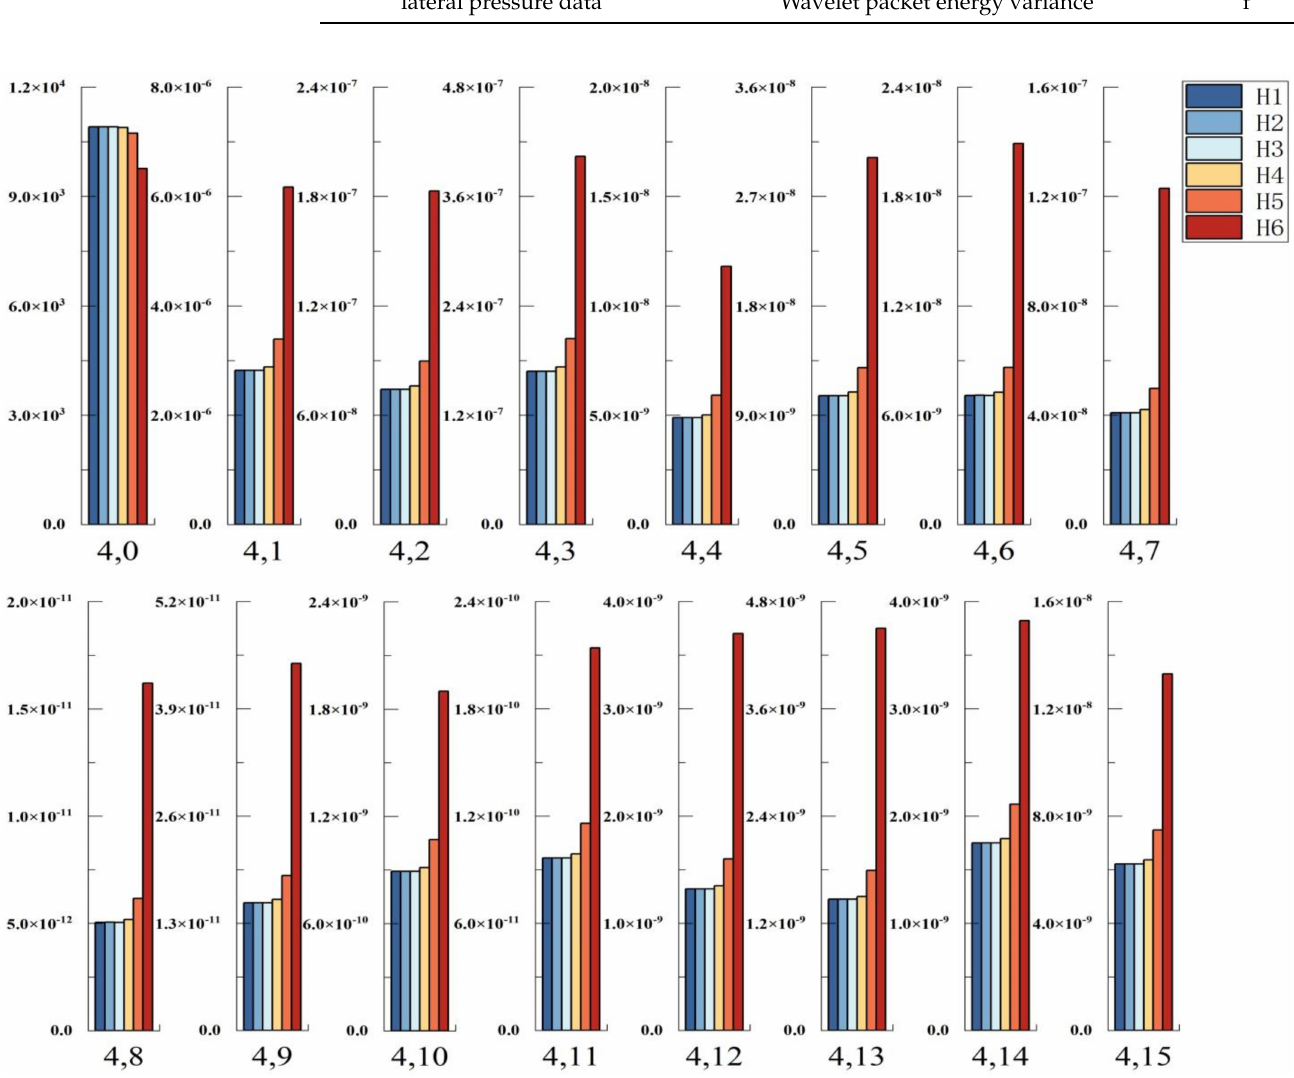
Figure 24. Characteristic energy of piston rod side pressure wavelet packet when reversing valve